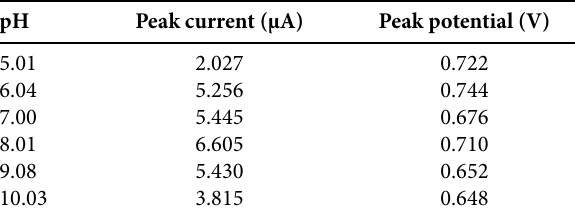
Table 1. Variation of peak potential and peak current of 1.52 × 10 –3 mol L –1 ziram solution at a scan rate of 0.050 V s –1 and different pH in 0.04 mol L –1 BR buffer solutions.